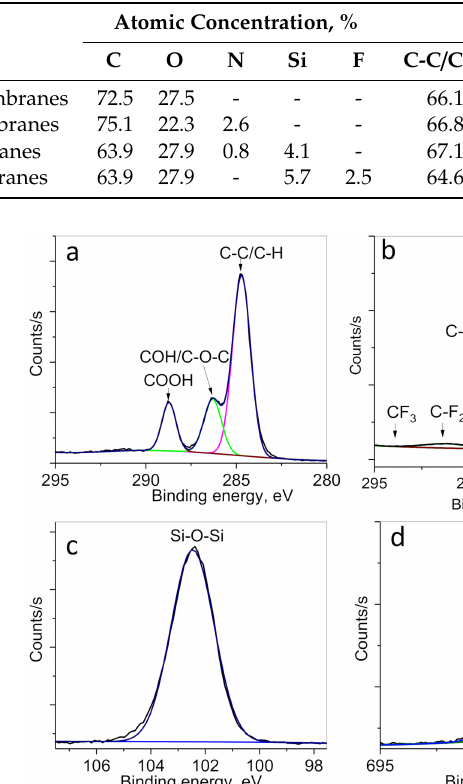
Figure 8. Typical high resolution XPS spectra of C1s ( a , b ), Si2p ( c ) and F1s ( d ) of the original PET ion-track membranes ( a ) and PET-Si-F membranes ( b – d ).